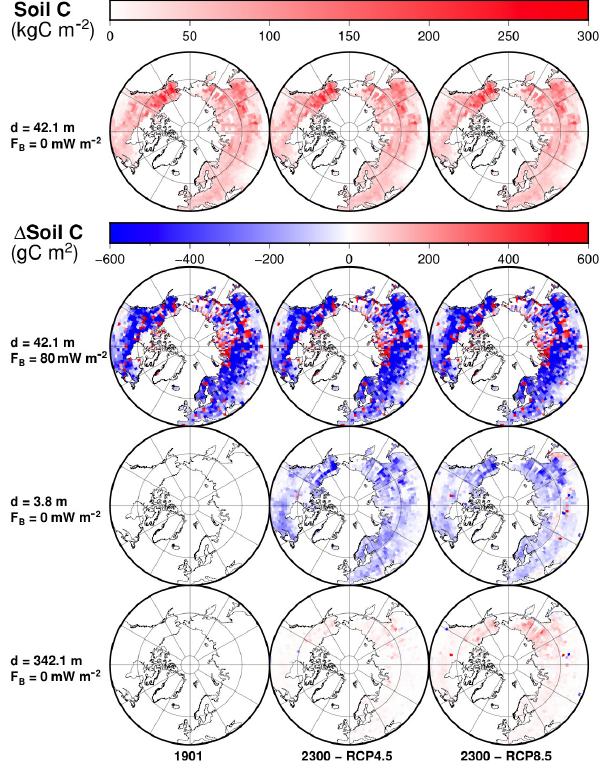
Figure 16. Distribution of vegetation carbon for the original model (top row) and differences to the original model at each time frame for the modified model with 80mWm − 2 (second row), the modi- fied model with d = 3 . 8m (third row) and the modified model with d = 342 . 1m (bottom row). Time frames are shown for 1901 and 2300CE for the RCP4.5 and RCP8.5 scenarios.